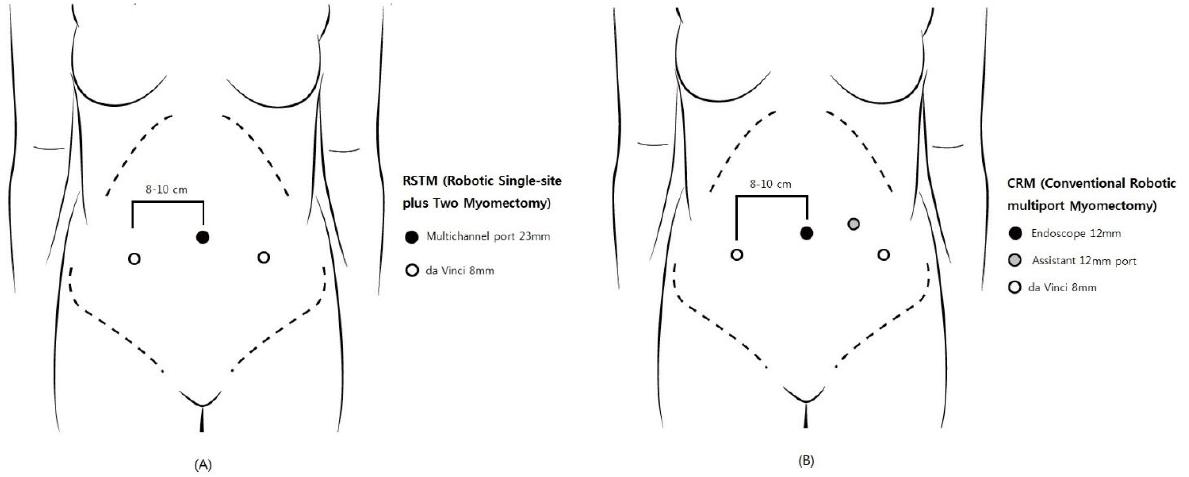
Figure 1. Comparison of trocar placement: ( A ) robotic single ‐ site plus two ‐ port myomectomy (RSTM); ( B ) conventional robotic multi ‐ port myomectomy (CRM).